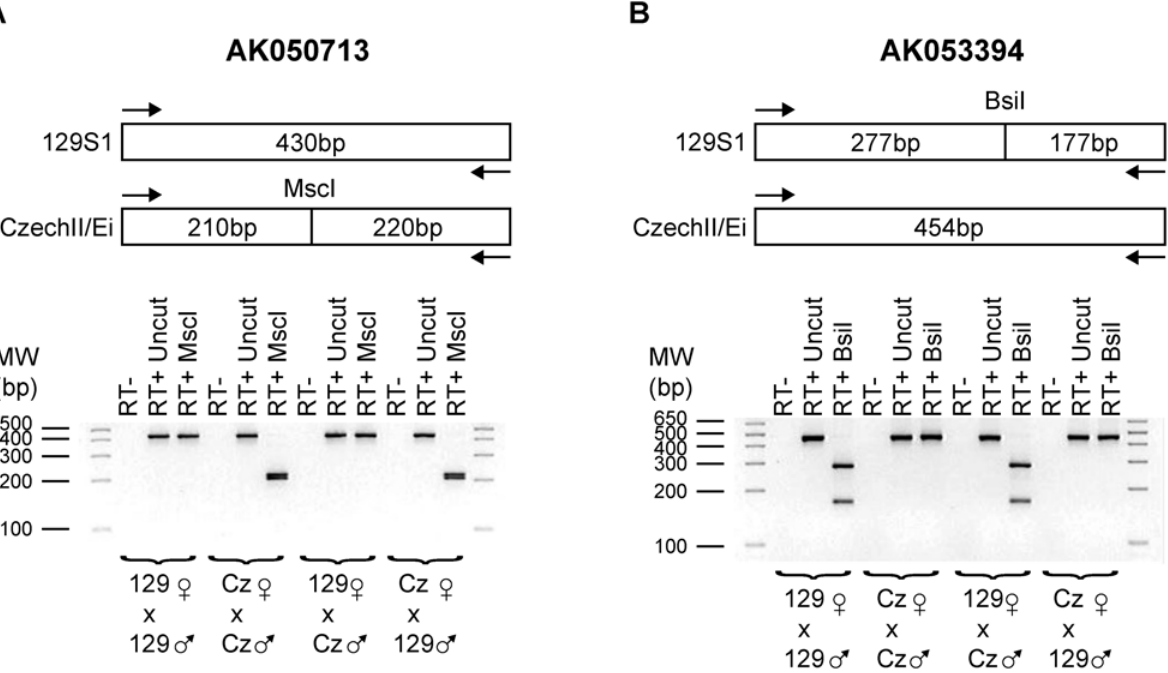
Figure 9. AK050713 and AK053394 are maternally expressed. (A) The AK050713 alleles contain an informative restriction site polymorphism in that a MscI site is present in the CzechII/Ei allele in comparison to 129S1. RT-PCR products with primers 784Up/1213Dn from the four intraspecific crosses were digested with and without MscI, verifying the imprinted expression of this gene. (B) Similarly, a BslI informative restriction site was utilized to demonstrate that AK053394 is maternally expressed using PCR primers 1647Up/2100Dn.